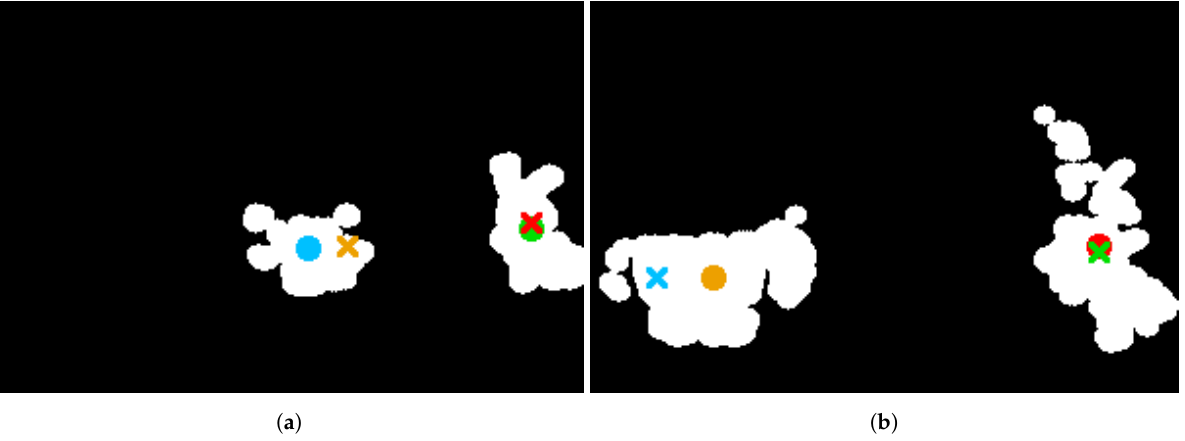
Figure 8. Region matching for two points of view. Circles: centroids, Crosses: warped centroids. ( a ) Point of view i (detail). ( b ) Point of view j (detail).